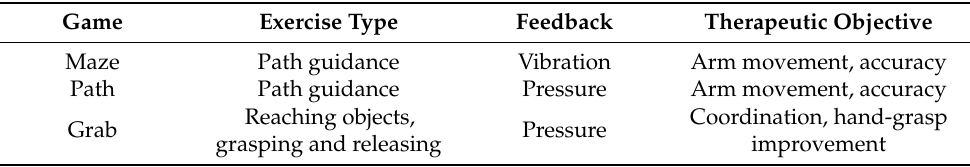
Table 1. Summary with the main characteristics of each game. Game Exercise Type Feedback Therapeutic Objective Maze Path guidance Vibration Path guidance Reaching objects, Coordination,